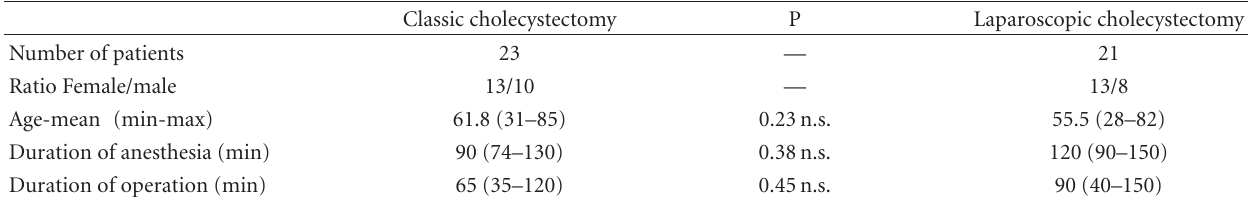
Table 1: Demographic and surgery-related data in patient groups for classic and laparoscopic cholecystectomy. Classic cholecystectomy